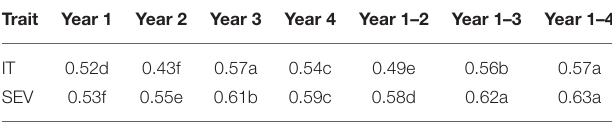
TABLE 6 | Comparison of the number of years in the training populations on overall GS model accuracy and pairwise comparisons for stripe rust infection type (IT) and disease severity (SEV) for PNW winter wheat over both the DP lines and BLs phenotyped from 2013 to 2020 in Central Ferry, Lind, and Pullman, WA, USA in the cross-validation